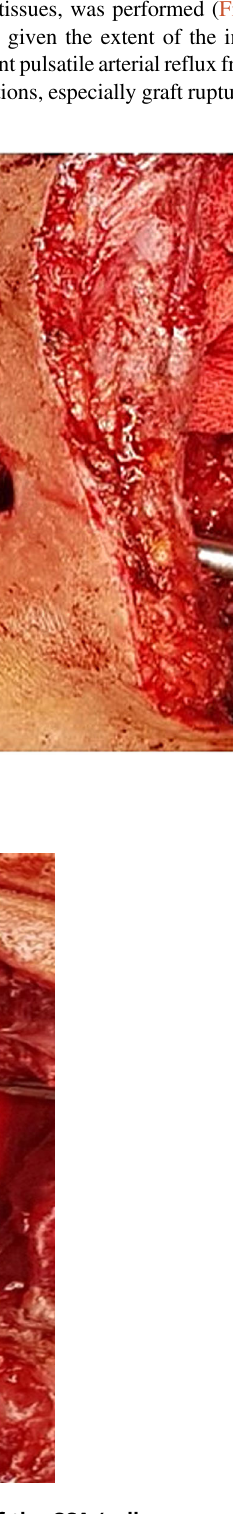
Figure 5. Preoperative view showing ligation of the two extremities of the CCA (yellow arrow) after total debridement of the infected area (green